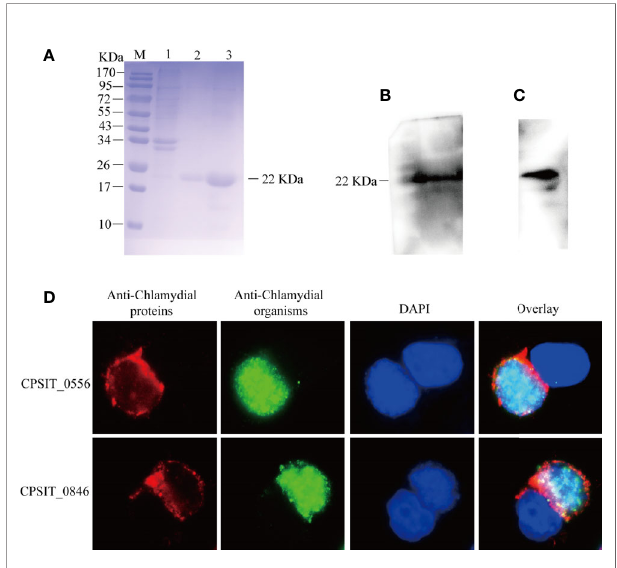
FIGURE 1 | Puri fi cation of CPSIT_0556 and subcellular localization in C. psittaci -infected HeLa cells. (A) CPSIT_0556 protein was separated by 12.5% SDS-PAGE, Lane 1: CPSIT_0556 in E. coli BL21 without IPTG, Lanes 2-3: Lanes 2 – 3: 300, 500 mM imidazole wash buffer, respectively. The recombinant CPSIT_0556 protein with a predicted size of 22 kDa. (B) CPSIT_0556 expression analyzed by Western blotting using the rabbit anti- C. psittaci mAb. (C) CPSIT_0556 analyzed by Western blotting using the anti-His labeled mAb. (D) C . psittaci 6BC infected HeLa cells for 48 h and then cells were probed with rabbit anti- C. psittaci mAb, mouse anti- CPSIT_0556, or mouse anti-CPSIT_0846 (red), the second antibody was Cy2-conjugated goat anti-rabbit IgG, Cy3-conjugated goat anti-mouse IgG, and DAPI. CPSIT_0846 was the positive control for inclusion membrane protein (×1000, in